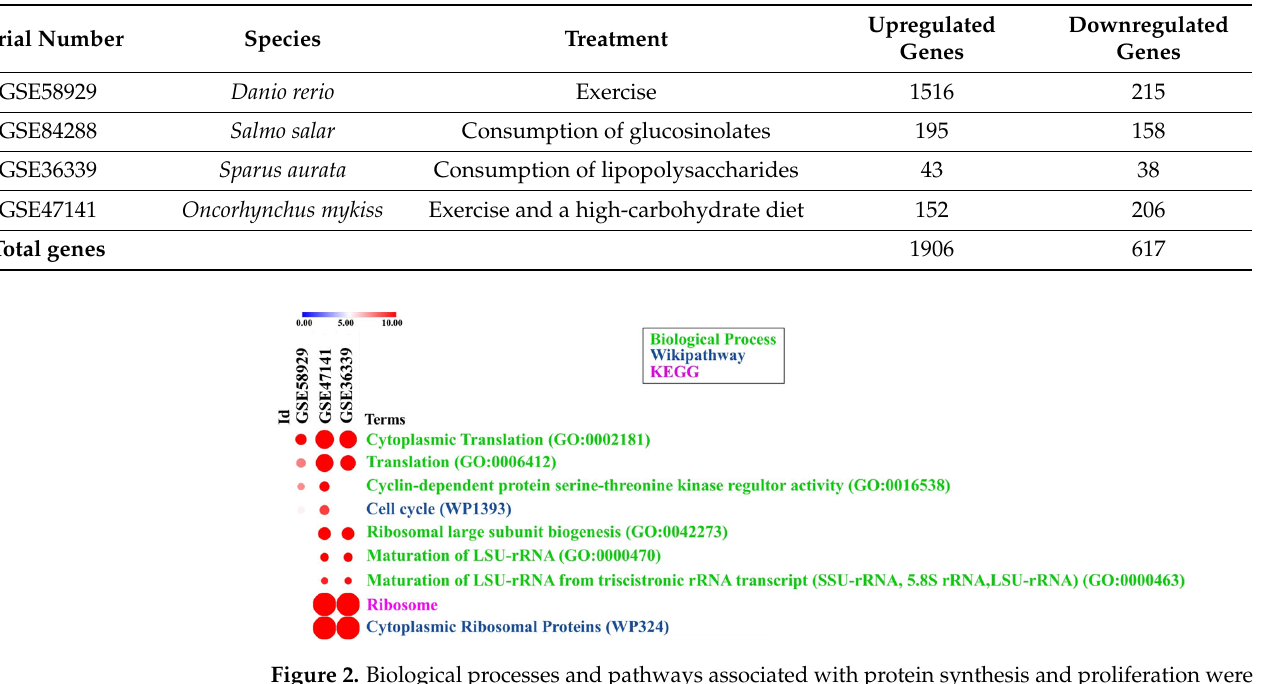
Table 2. Identification, characterization, and number of genes from each study included in the data analysis.